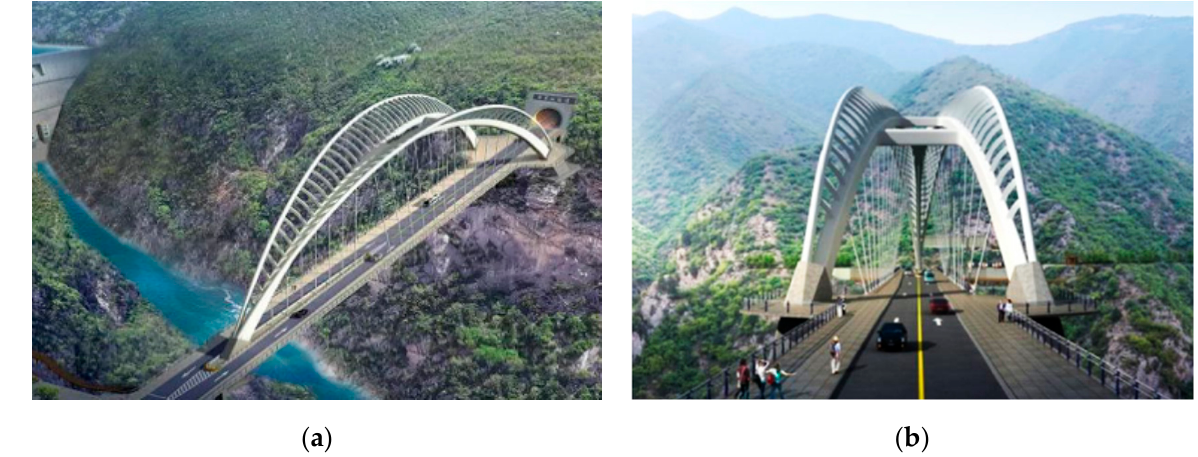
Figure 1. Three-dimensional rendering of main and secondary arch collaborative Y-shaped steel box arch bridge: ( a ) isometric drawing; ( b ) side-view drawing.